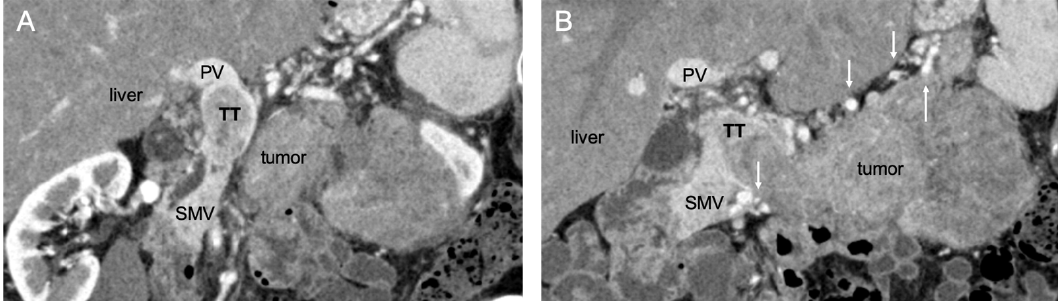
Figure 2. Coronal computed tomography images of ( A ) a large left-sided pNET with complete occlusion of the PV and ( B ) extension of the tumor thrombus and resultant surrounding varices (white arrows). PV, portal vein; TT, tumor thrombus; SMV, superior mesenteric vein.